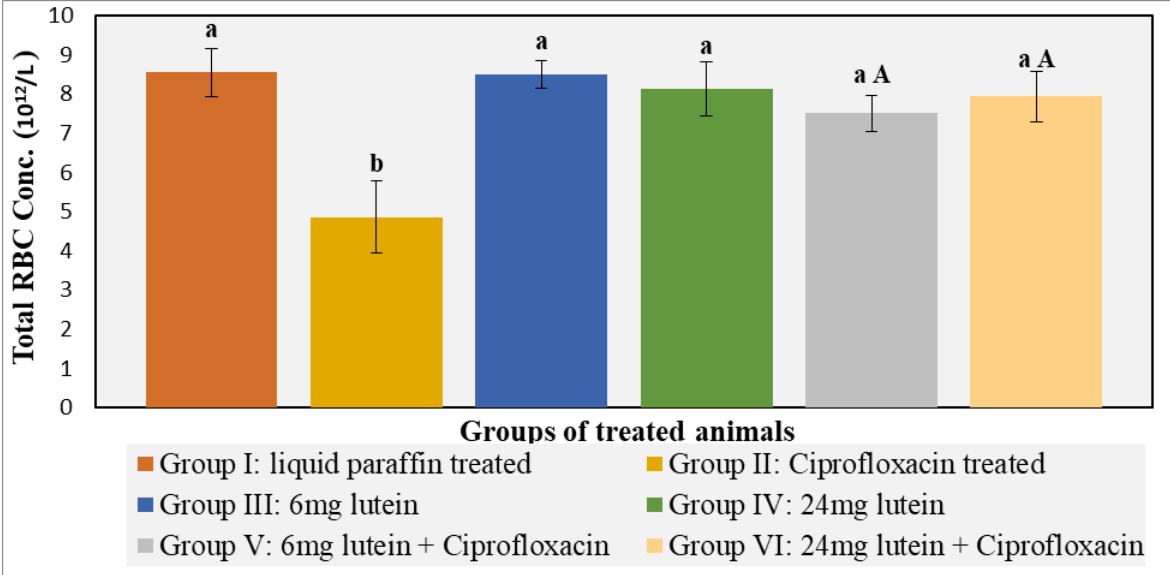
Figure 1. Effects of various treatments on Total RBC counts in rats. Data are expressed as Mean ± SD, n =6. Values with non-identical small letters (a, and b) are significantly different ( P < 0.05). Values with an identical capital letter (A) are non-significantly different ( P > 0.05).